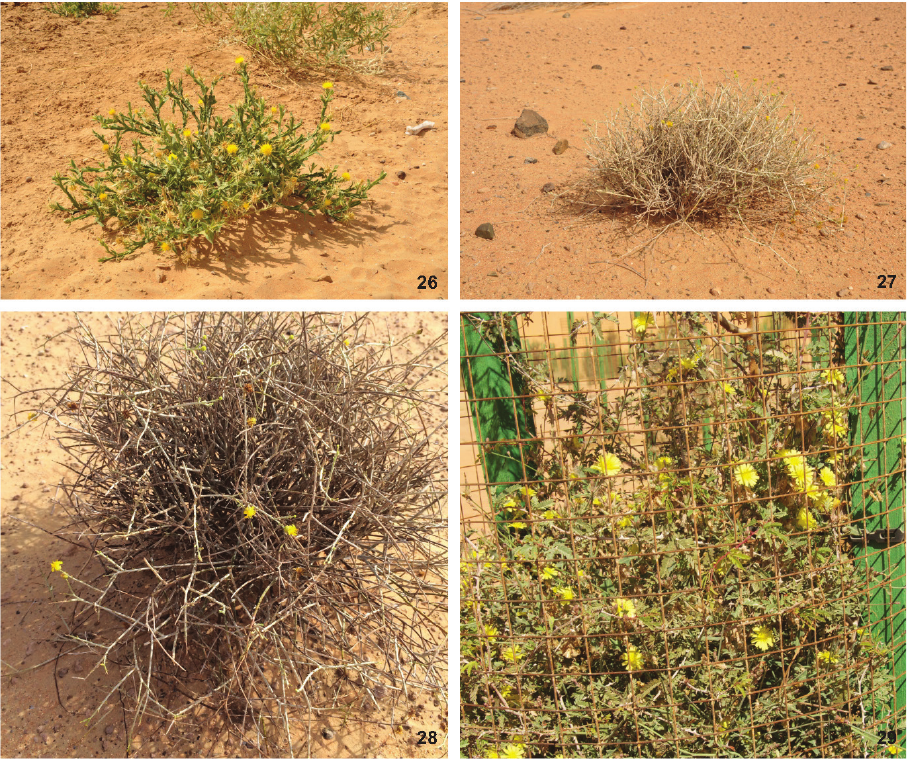
Figures 26–29. Asteraceae: 26 Centaurea pseudosinaica 27, 28 Rhanterium epapposum 29 Launaea